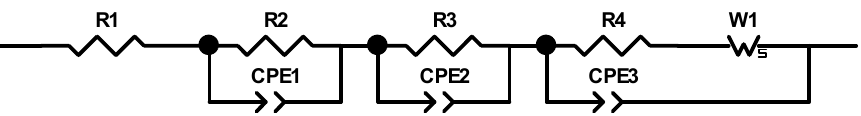
Figure 11. Equivalent circuit for the pouch cells with ohmic resistances (R1, R2, R3, R4), constant phase elements (CPE1, CPE2, CPE3), and finite length Warburg element (W1).